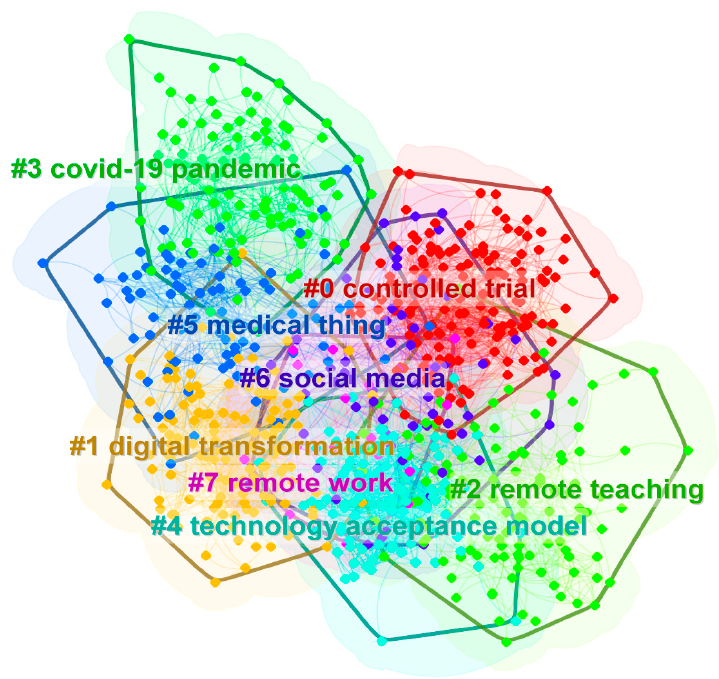
Figure 4. Clustering distribution of keyword co-occurrence network (cluster view). This figure cor- responds to Figure 3 and omits the labels of all nodes, which highlights the clustering categories and the corresponding nodes. The color of the label indicates the category and the nodes that belong to a specific category present a boundary.